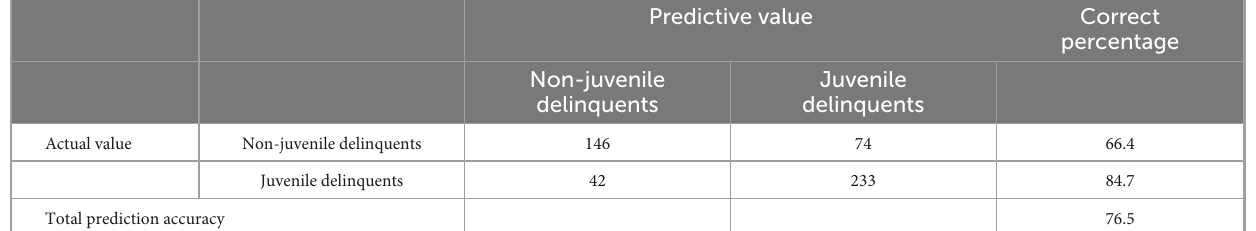
According to the cross table of prediction